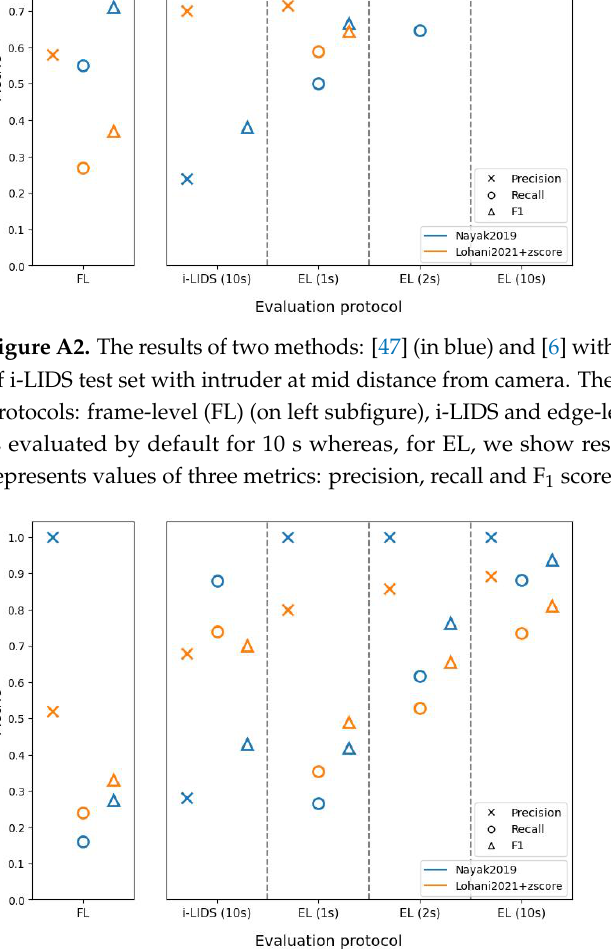
Figure A3. The results of two methods: [47] (in blue) and [6] with z-score (in orange), tested on view 2 of i-LIDS test set with intruder at far distance from camera. The abscissa represents three evaluation protocols: frame-level (FL) (on left subfigure), i-LIDS and edge-level (EL) (on right subfigure). i-LIDS is evaluated by default for 10 s whereas, for EL, we show results for 1, 2 and 10 s. The ordinate represents values of three metrics: precision, recall and F 1 score.